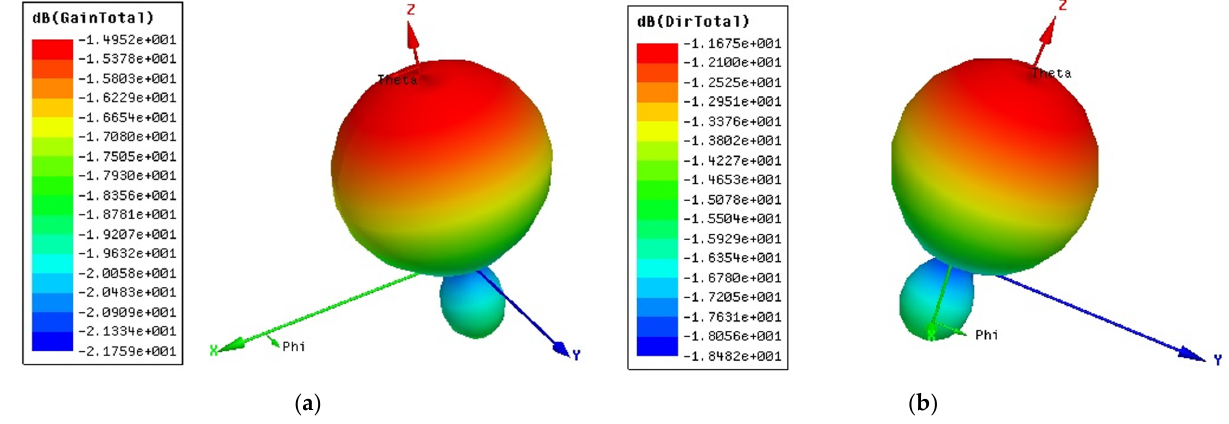
Figure 10. The radiation pattern of the developed IoT antenna: ( a ) gain and ( b ) directivity.